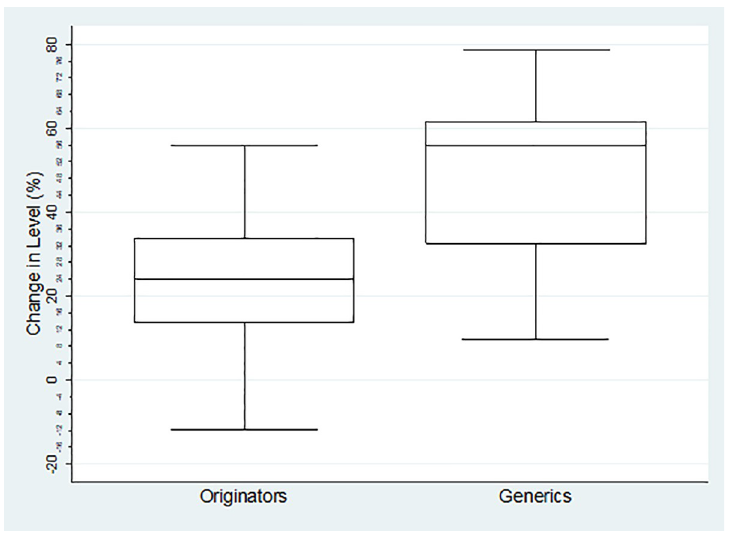
Fig 2. Percentage change in level in the Regional Core Basket.